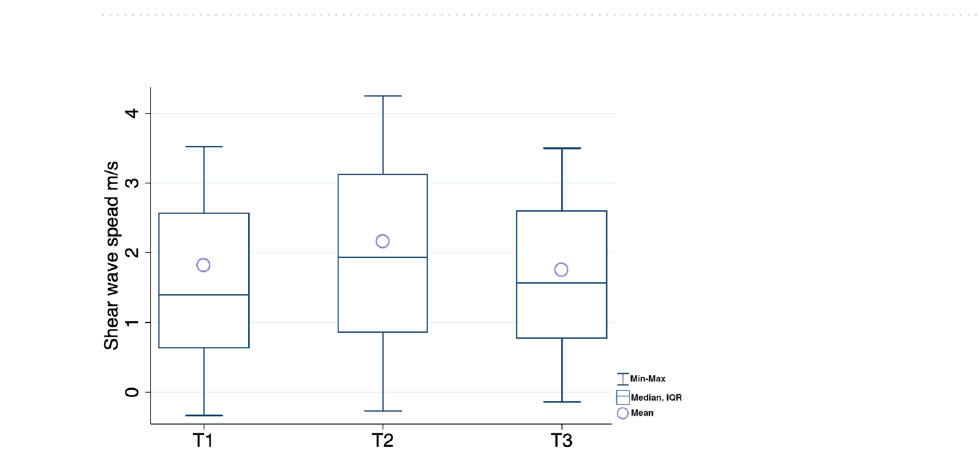
Figure 2. Box ‐ and ‐ whisker plot showing shear wave speed mean and median at the three different time points. T1: measures after fetal delivery, T2: measures after placental delivery, T3: measures 30 min after placental